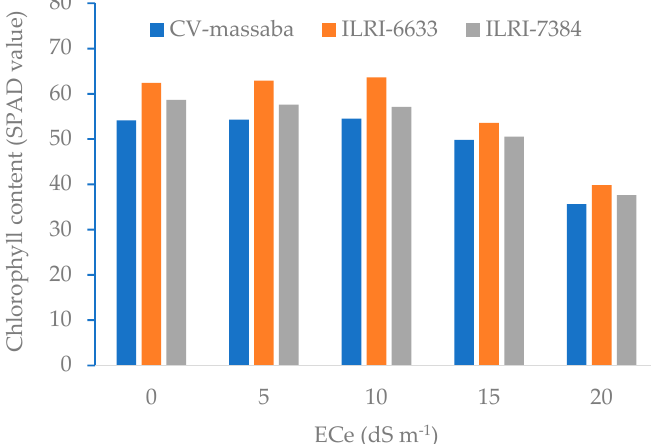
Figure 3. Effect of different salinity levels on chlorophyll content (SPAD value) of three selected Chloris gayana genotypes.